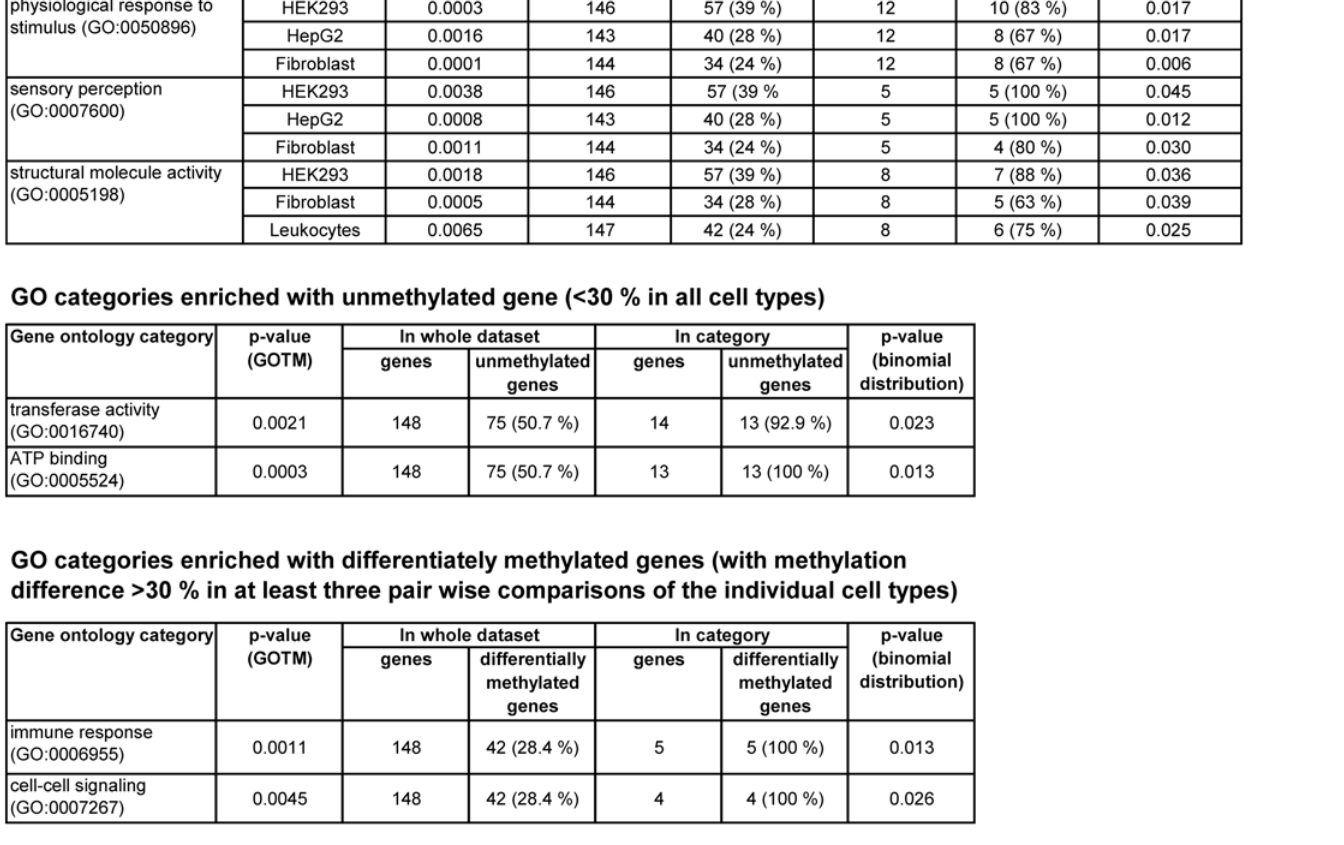
Figure 8. Gene ontology analysis of genes with different methylation states.